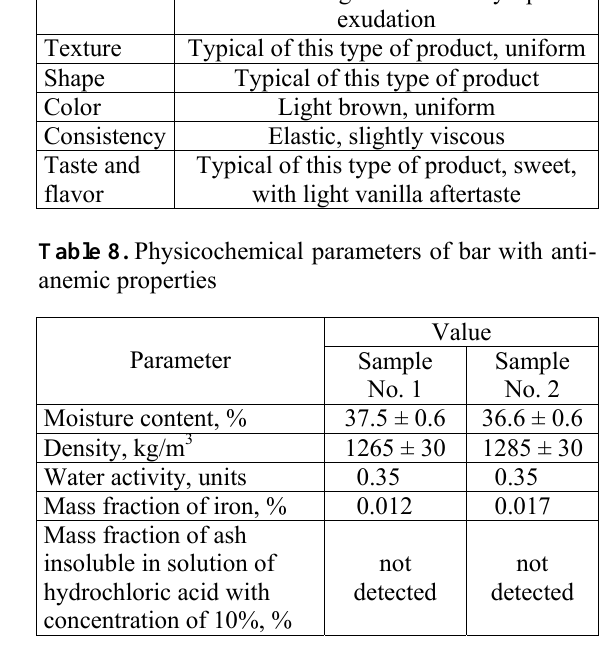
Table 9. Content of toxic